Question: In one sentence, what is this figure communicating?
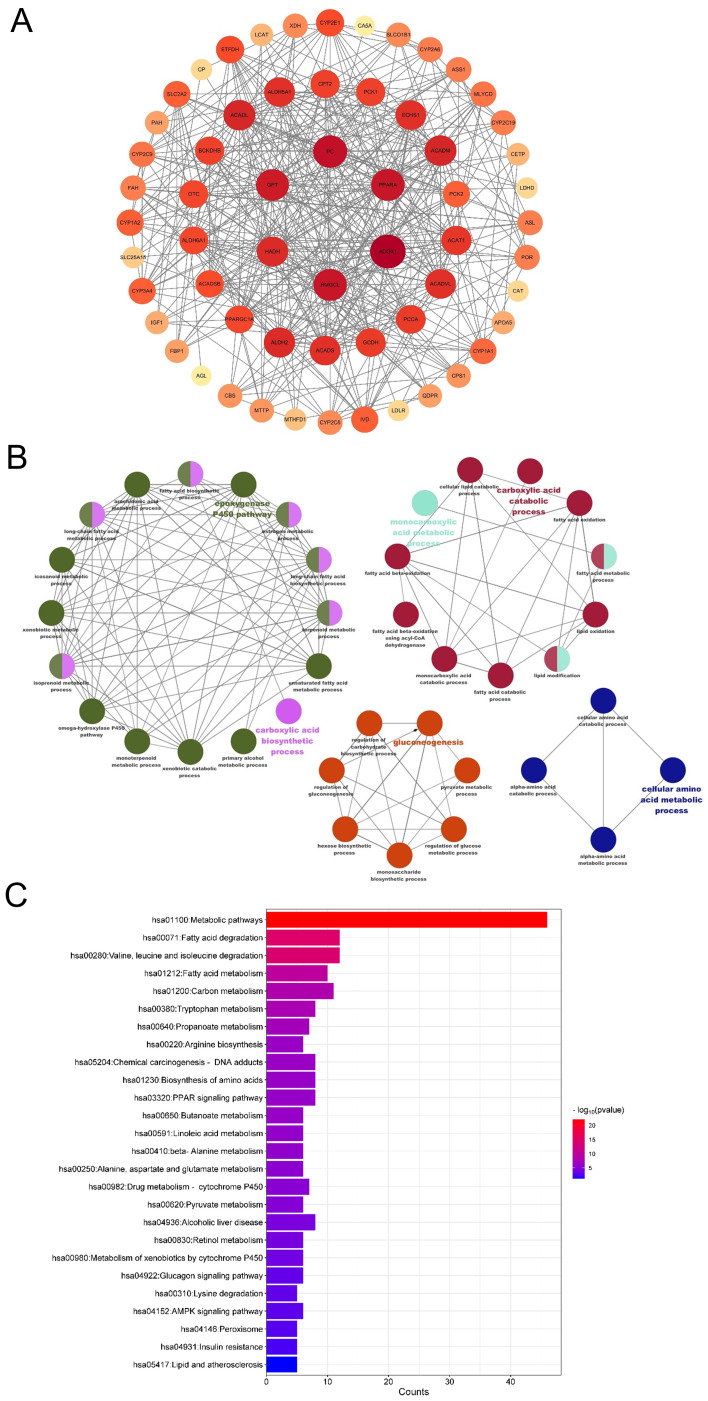
Answer: Explore the biological functions of LMRGs. (A) Protein-protein interaction (PPI) network of LMRGs generated using STRING and visualized with Cytoscape. Node color indicates degree value, defined as the number of direct connections between a given gene/protein node and other nodes in the network. A higher degree value indicates greater connectivity and potential centrality within the PPI network, with colors changing from yellow to red to represent increasing degree values. (B) Gene Ontology (GO) enrichment analysis of LMRGs performed using ClueGO. (C) Kyoto Encyclopedia of Genes and Genomes (KEGG) pathway enrichment analysis of LMRGs. For enrichment analyses, P < 0.05 was considered statistically significant.